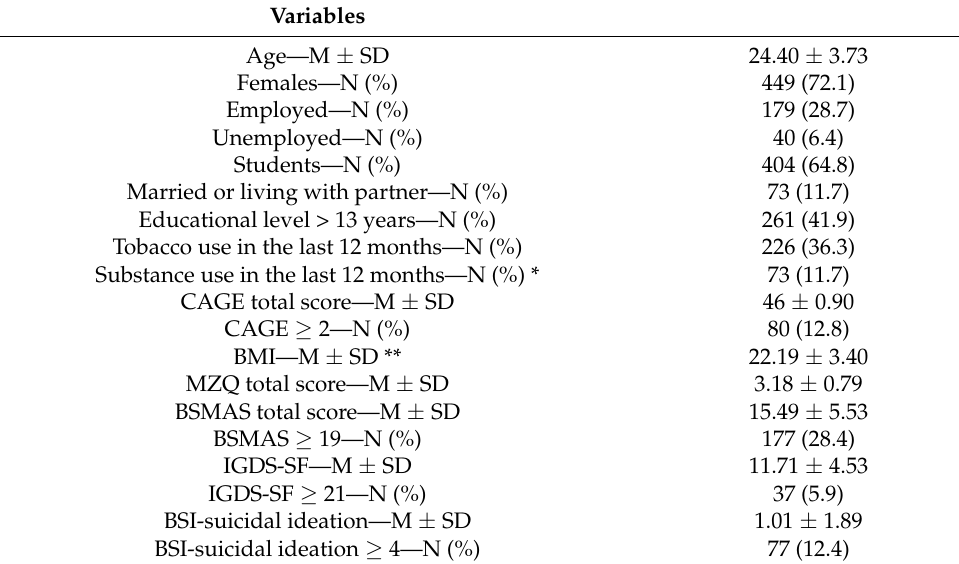
Table 1. Descriptive statistics for the sample (N =